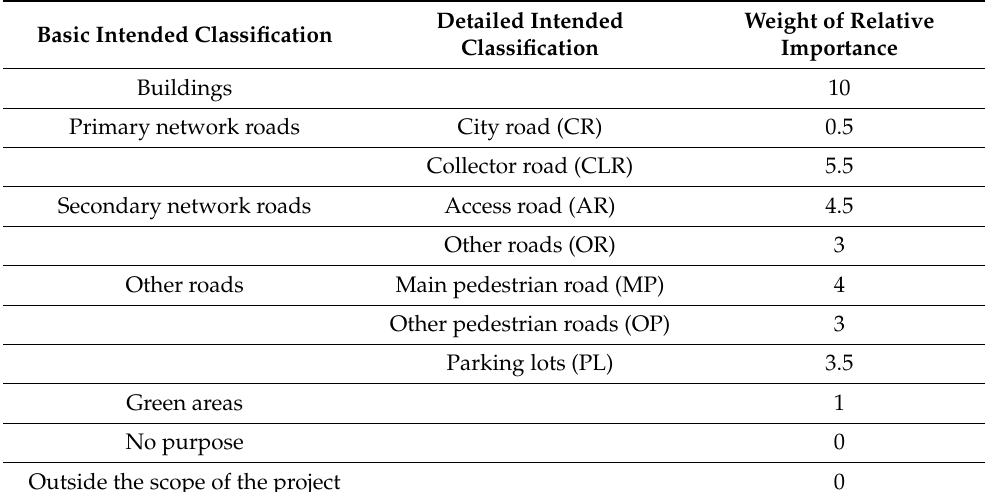
Table 3. Intended classification of elements according to the UDP of the Campus of the University of